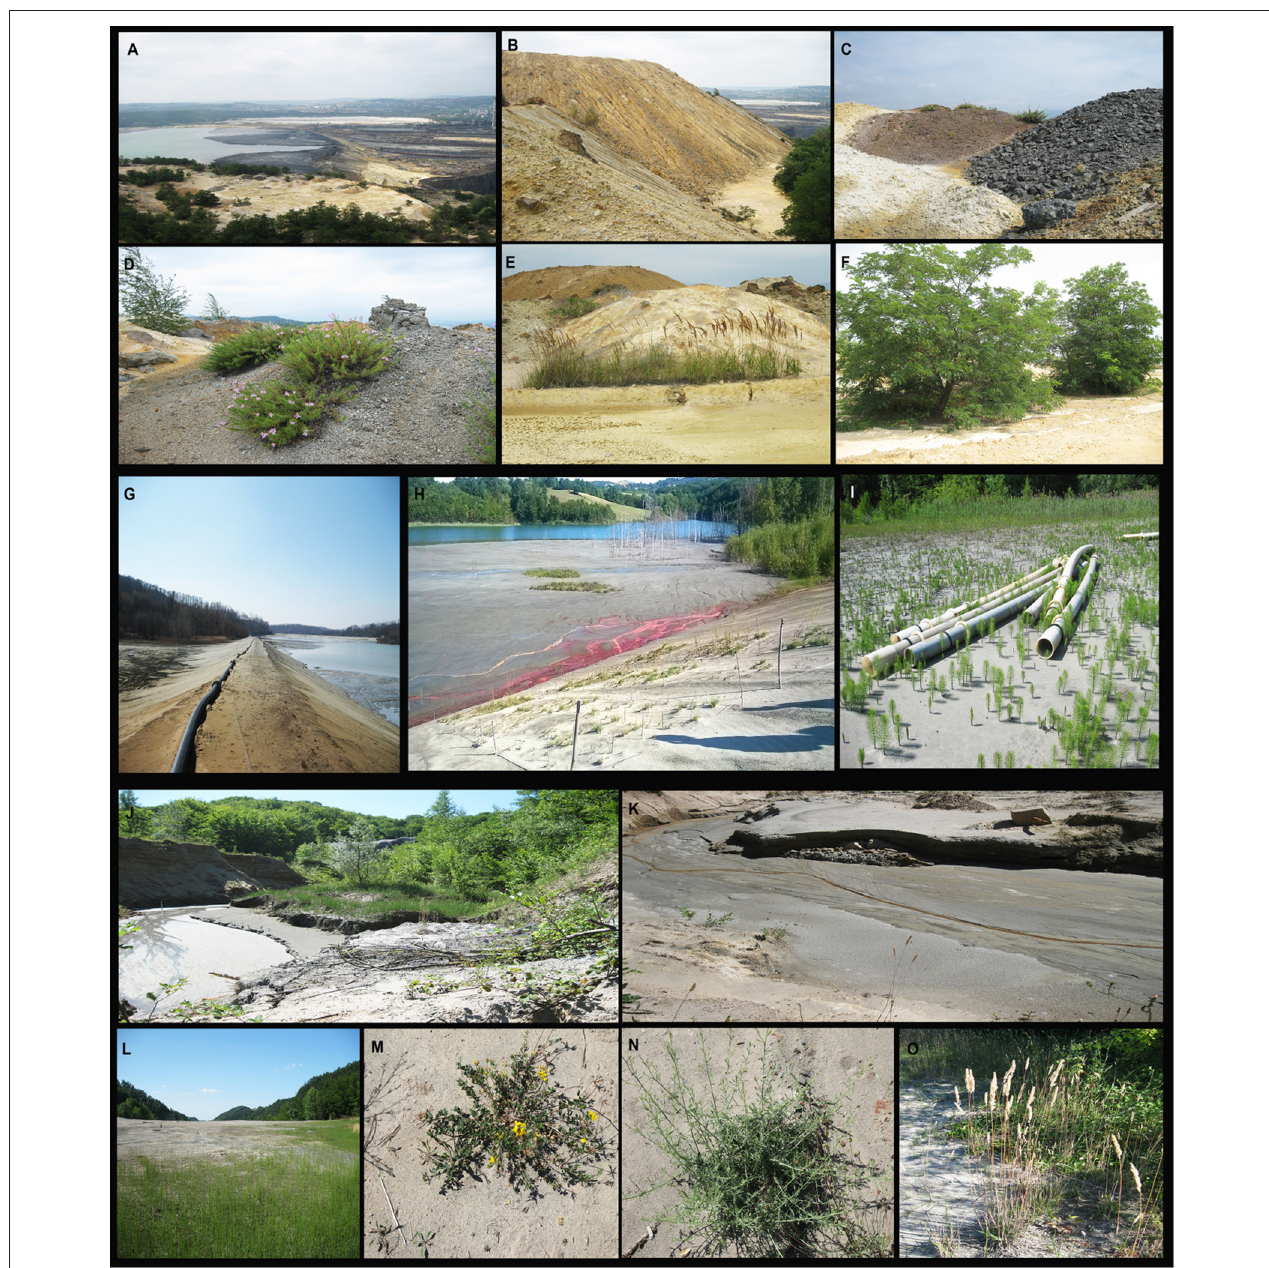
FIGURE 2 | Mine waste in Serbia: copper mine waste in metalliferous Bor region (A–C) with Epilobium dodonaei (D) , Calamagrostis epigejos (E), and Robinia pseudoaccacia (F) ; mine flotation tailings at the Pb/Cu/Zn mine “Rudnik” (G–H) with spontaneously colonized Equisetum sp. (I) ; antimony flotation tailings “Stolice” after accidental flooding event with spontaneously colonized plant species 1 year later (J–O) .